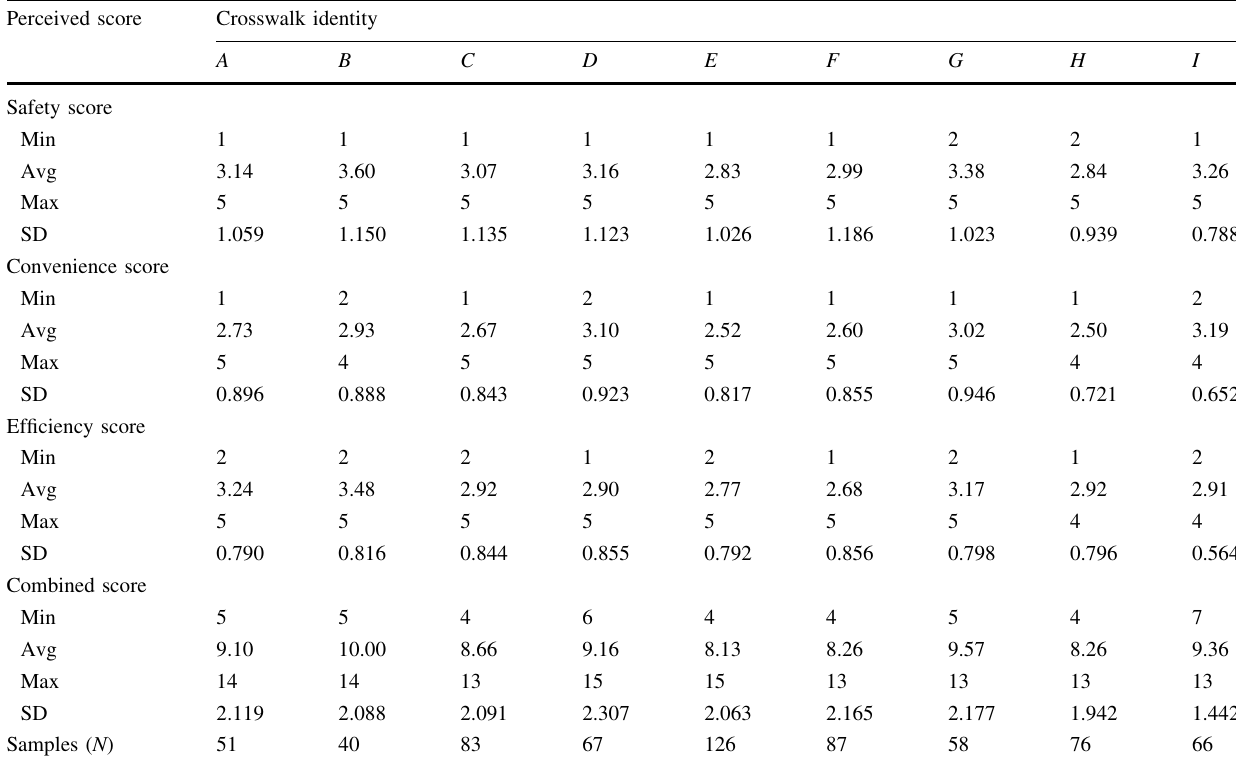
Table 5 Descriptive statistics of pedestrian perception score Perceived